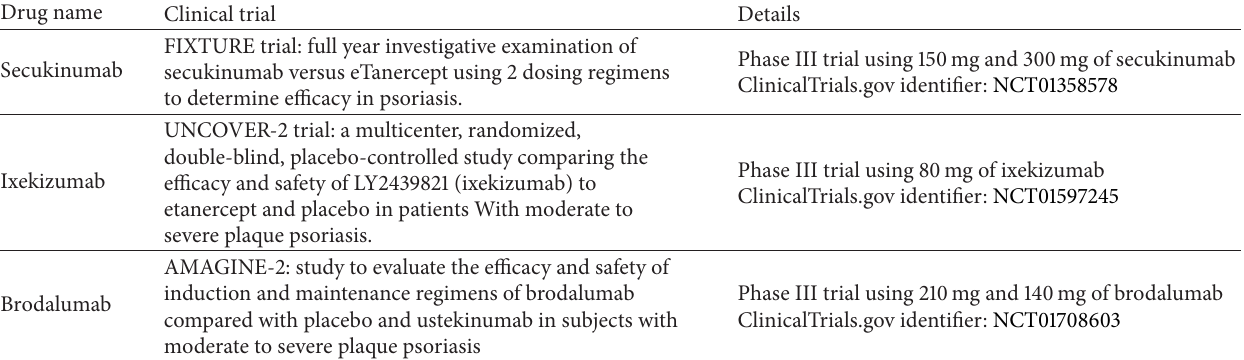
Table 1: The current clinical trials for monoclonal antibody treatments available in targeting